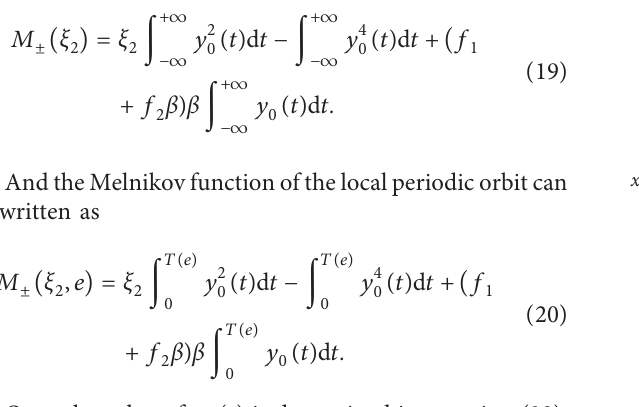
� 0 . 1 ,f � 1 , f � 0, and τ � 0 . 3. 2 1 2